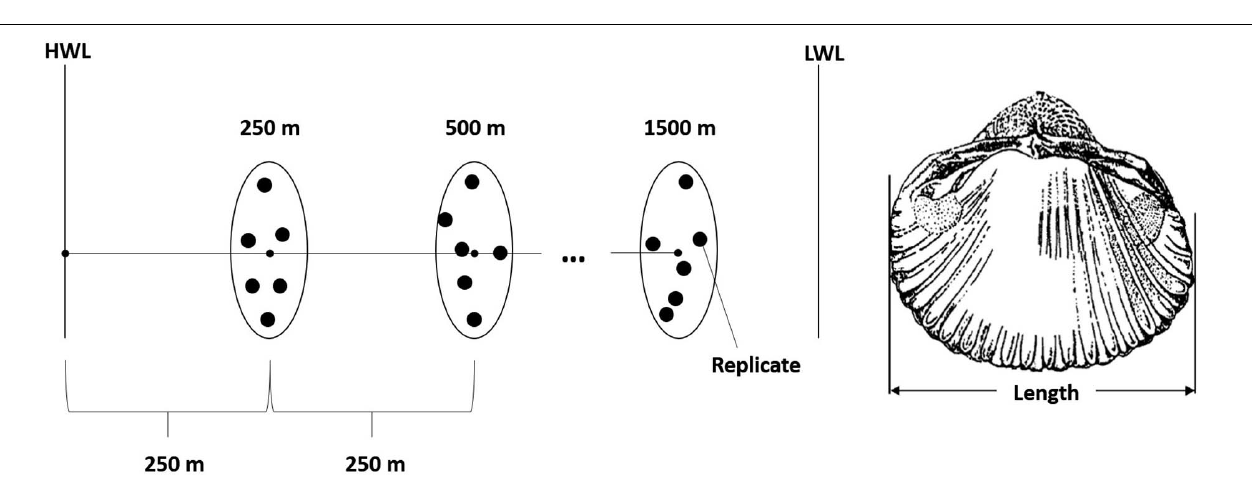
FIGURE 2 | Sampling design from high (HWL) to low water line (LWL) and cockle length measurement.